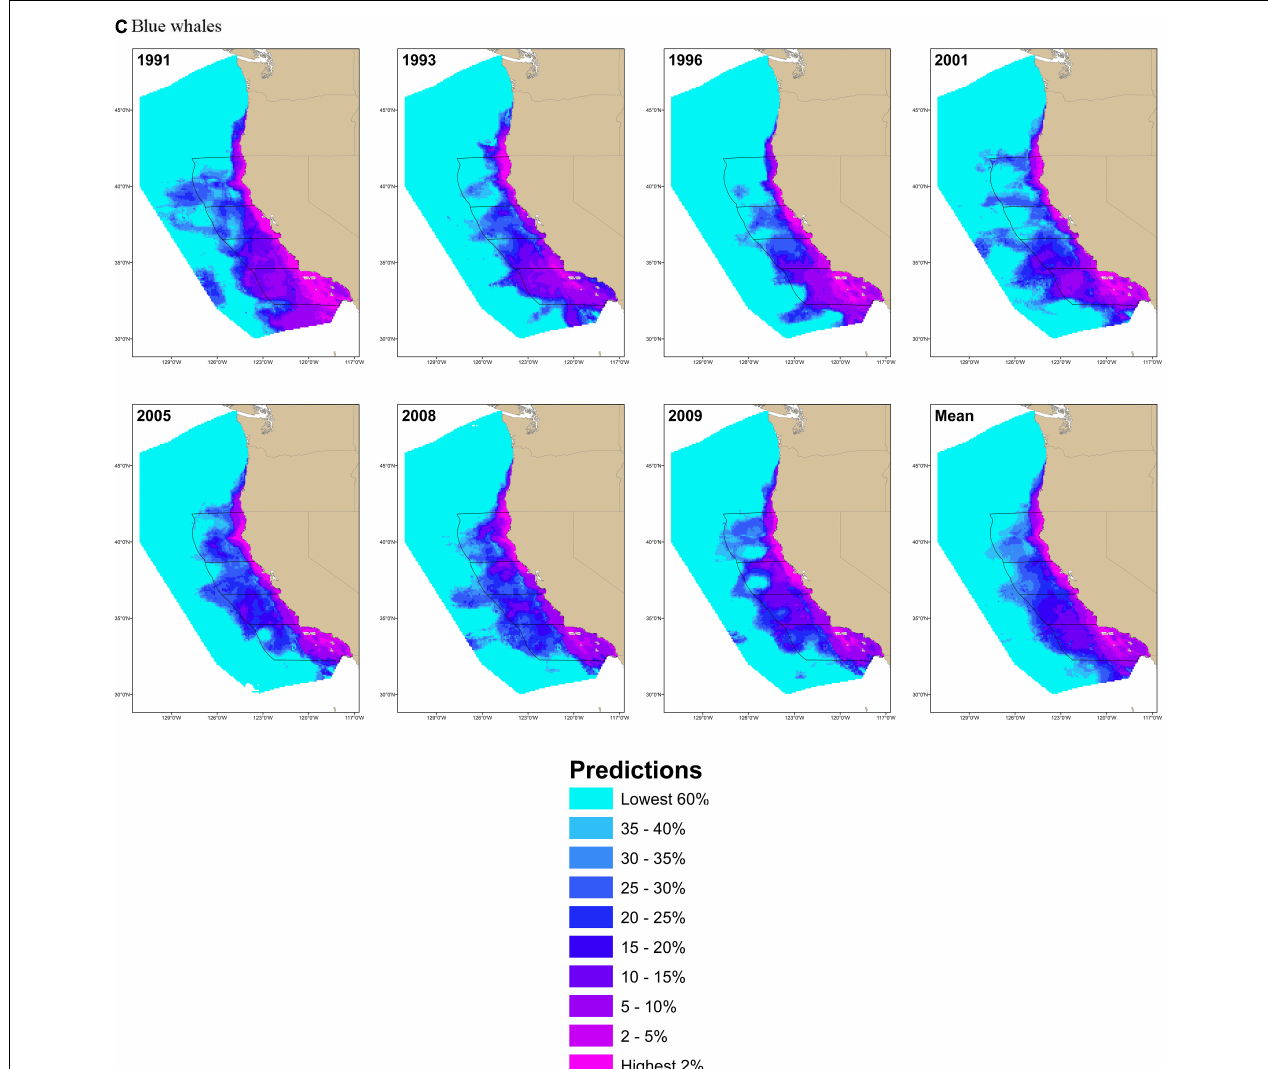
FIGURE 2 | Maps of annual and mean predicted species distributions for (A) fin, (B) humpback, and (C) blue whales. Habitat variables were derived from in situ and remotely sensed oceanographic data for humpback whales and output from a Regional Ocean Modeling System for fin and blue whales. Data from the 2009 survey could not be used in the humpback whale models because the survey and, concomitantly, the in situ oceanographic sampling did not cover the entire study area. Surveys were only conducted off California in 1991 and 1993; consequently, predictions of humpback whale distributions could not be made off Oregon and Washington in these 2 years. Other differences in the study area boundary for humpback whales and missing predictions within the study area (white grid cells) arise from gaps in oceanographic sampling. The highest 2, 5, 10, ... , and 40% of predicted values were calculated using the mean predicted densities. Data from all years were categorized using the values from the mean to show changes in density among